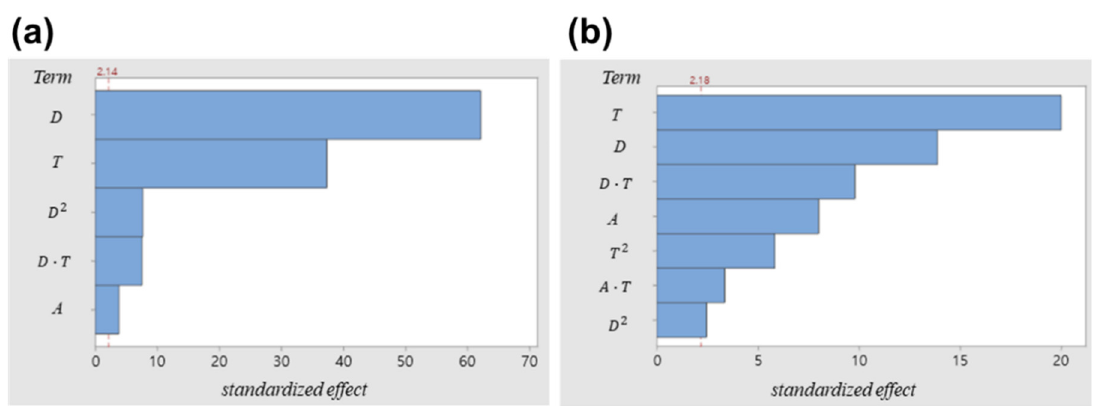
Figure 13. Effect of terms for ( a ) maximum stress and ( b ) number of springs for spring module.